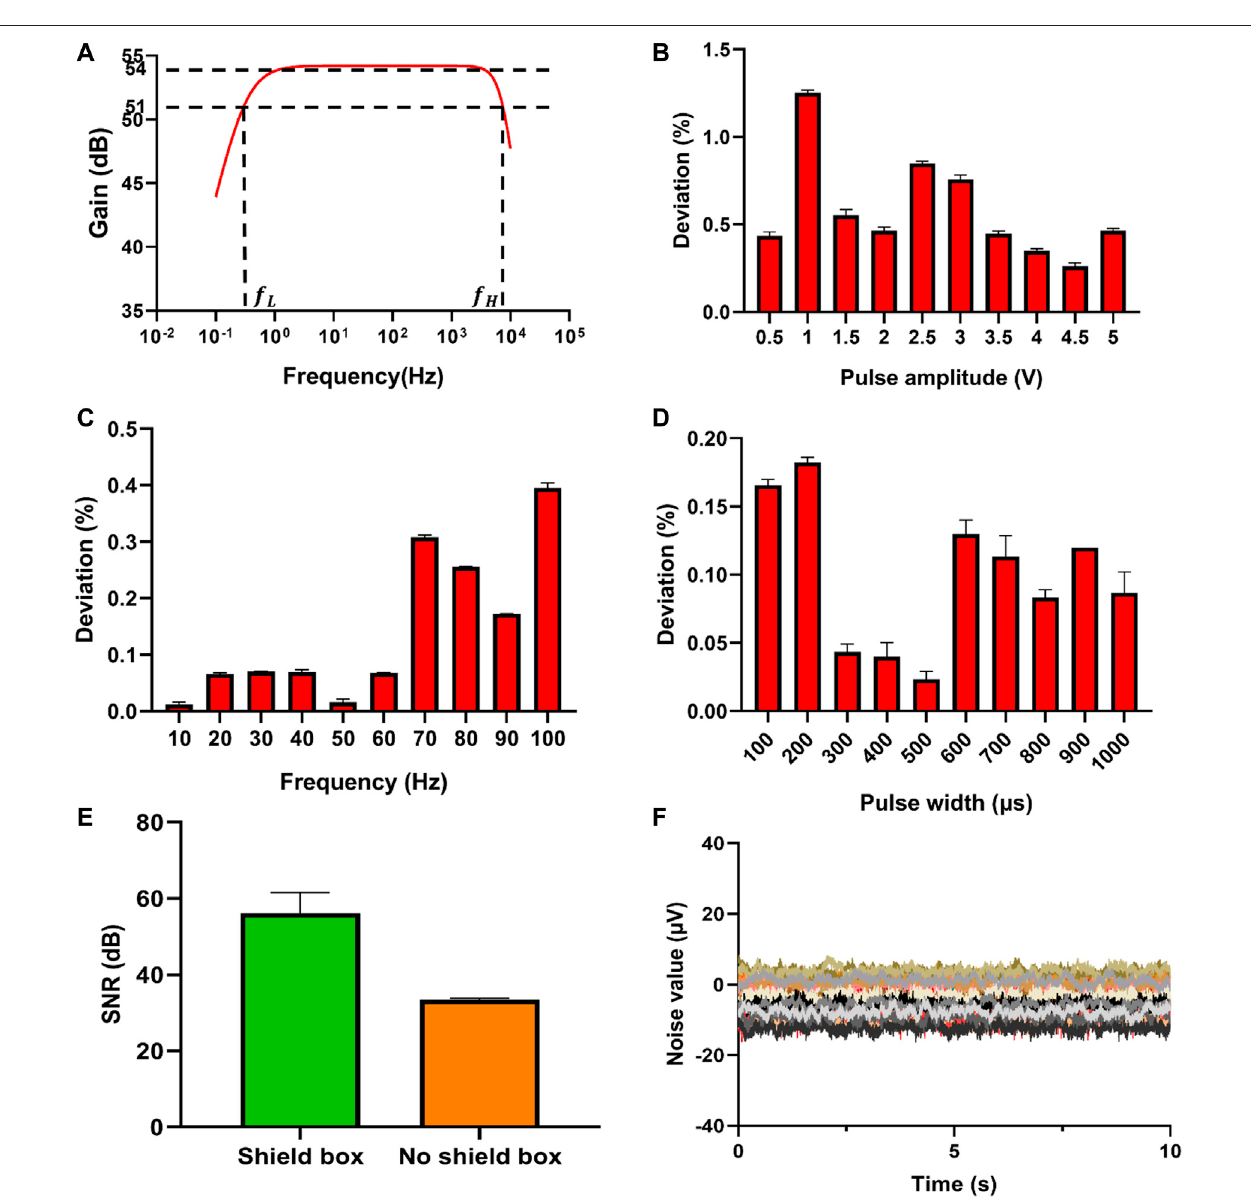
FIGURE 4| Performance test of the electrical signal recording and electricalpulse regulating system. (A) Bode plot of thesignal processing circuit. (B) Deviation of thepulseamplitudegeneratedbyDAQ. (C) DeviationofthepulsefrequencygeneratedbyDAQ.Inactualexperiments,thefrequencyrangeoftheelectroporationpulses is10 – 100 Hz,sothecommonlyusedfrequencypointsareselectedfortesting. (D) DeviationofpulsewidthgeneratedbyDAQ. (E) SNRcomparisonbetweenshieldbox and no shield box. (F) Sensor performance test of NPMEA with PBS (Curves in different colors represented all 32 channels of a sensor).